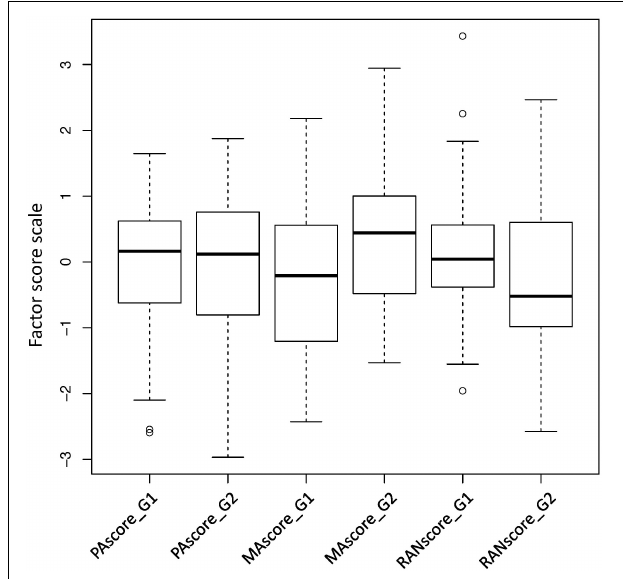
FIGURE 1 | Box plots of factor scores derived from phonological, morphological and rapid naming measures in Grades 1 and 2, respectively. PAscore_G1(2): phonological awareness factor score in Grade 1(2); MAscore: morphological awareness factor score in Grade 1(2); RANscore: rapid naming factor score in Grade